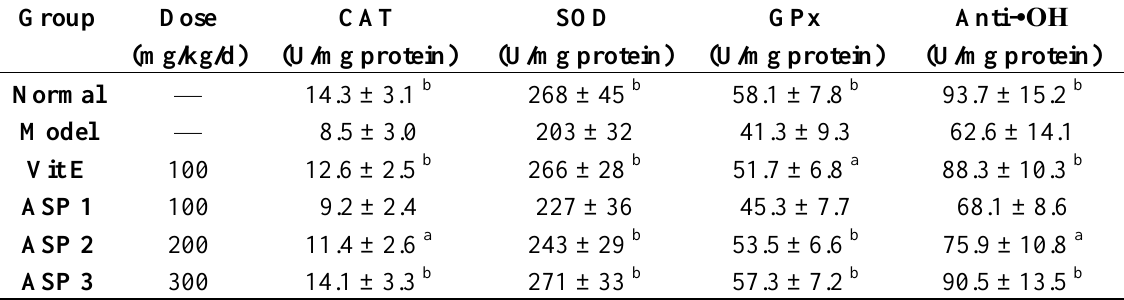
Table 5. Effects of APS on the CAT, SOD, GPx and anti-hydroxyl radical activities in mice liver in vivo (n =10). Data were expressed as means ± S.D. and statistical differences between groups were analyzed by one-way analysis of variance